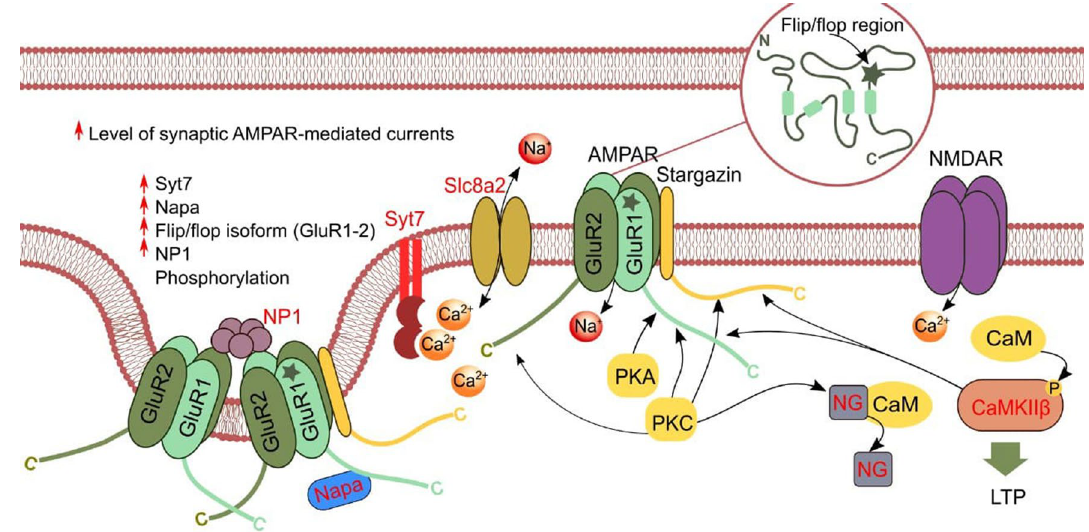
Figure 6. Schematic diagram illustrating the role of proteins encoded DEGs and DASGs and others on AMPA- receptor signaling and synaptic plasticity. mRNA expression of NSF-attachment protein alpha ( Napa ), pentraxin 1 ( Nptx1 , NP1), synaptotagmin 7 ( Syt7 ), neurogranin ( Nrgn , Ng), Slc8a2 , and Camk2b was higher in the HP group (corresponding to the proteins highlighted in red). The HP group also has an increased flip/flop transcript ratio of subunits Glur1 and Glur2. The flip isoform renders AMPA receptors less prone to desensitization as compared to the flop isoform, but AMPA receptor affinity for glutamate remains unchanged 48,91 . Fast, excitatory synaptic transmission in the brain is primarily mediated by two types of ionotropic glutamatergic receptors: AMPA and NMDA receptors. Calcium entry through postsynaptic NMDA receptors activates intracellular signaling cascades including calmodulin (CaM) and CaMK2 signaling. Ng concentrates CaM to participate in postsynaptic signaling processes 92,93 . Ng phosphorylation by PKC disrupts its